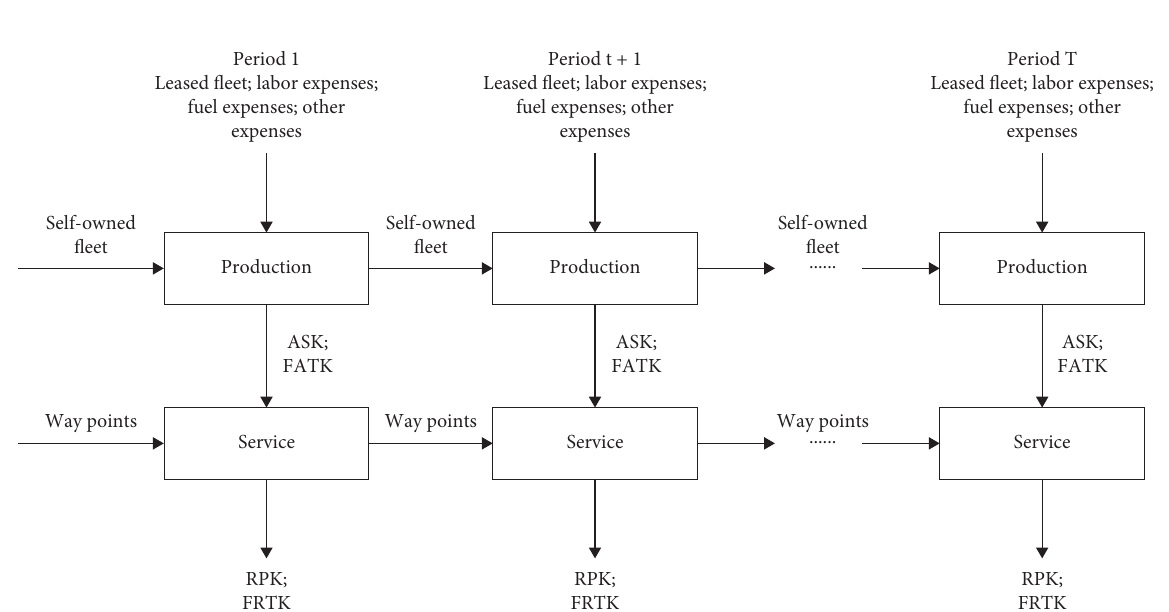
Figure 5: Dynamic network structure in